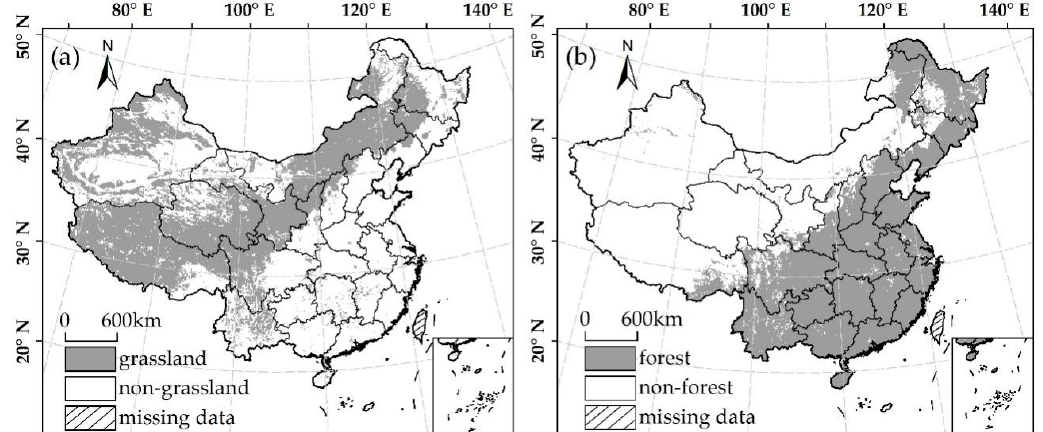
Figure 3. The potential extents of natural ( a ) grassland (PENG) and ( b ) forest (PENF) without land reclamation.